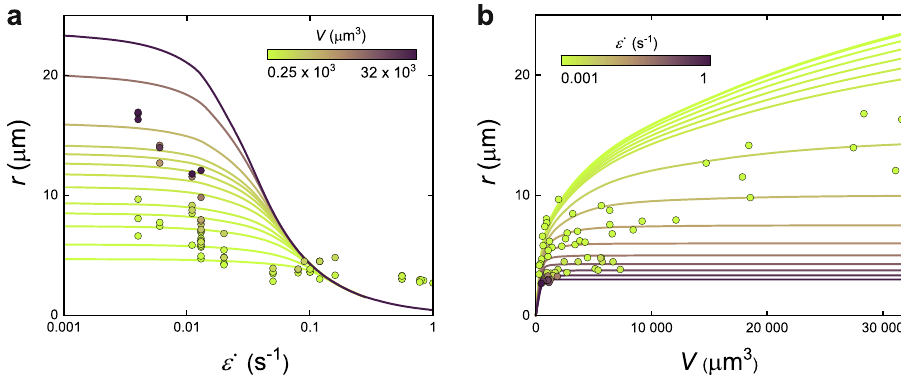
Fig. 3 Maximum deformation of tactoids under various extension rate. a The theory (lines) and the experimental data (symbols) predict that short axis of the tactoids r decreases as the extension rate _ ε increases where r lines, corresponding to tactoids with different volumes V , converge to a single curve at large values of extension rate. b At a given extension rate, the short axis of the tactoids increases logarithmically with an increase in the volume of the